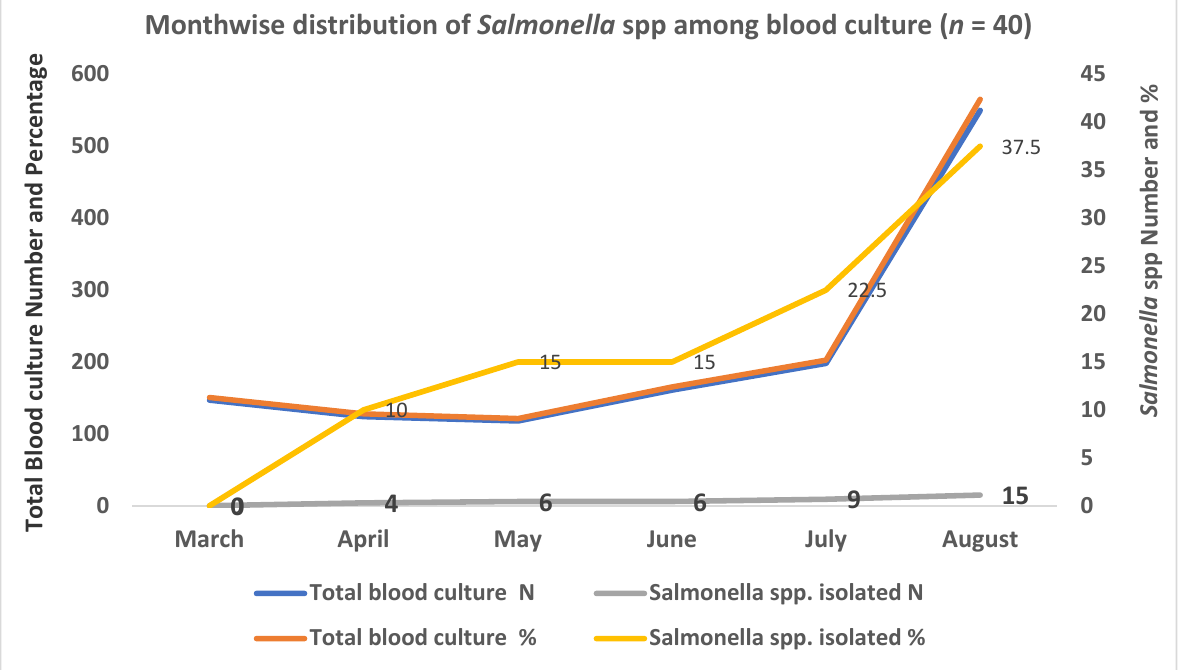
Figure 2. Monthwise isolation of Salmonella spp. from blood specimens.